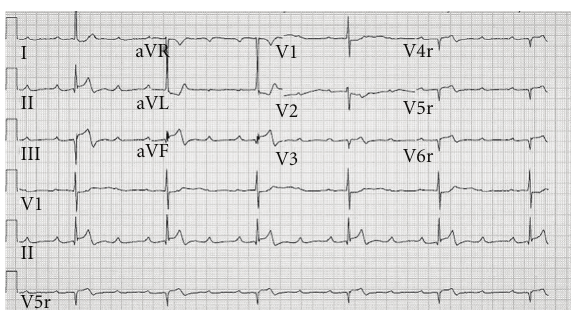
Figure 1: Right-sided surface electrocardiogram demonstrating 3rd-degree A-V block and a slow junctional escape rhythm, inferior ST segment elevations with reciprocal lateral ST segment depres- sions, inferior Q waves, prominent R wave in V1, and right-sided ST elevations in leads V4r–V6r suggesting acute right ventricular myocardial